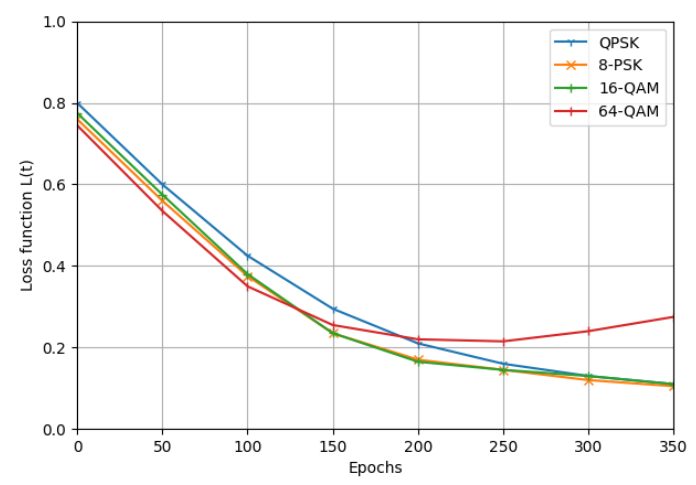
Figure 11. Loss function versus number of epochs for the proposed CNN-based SIC scheme with varying modulation order.